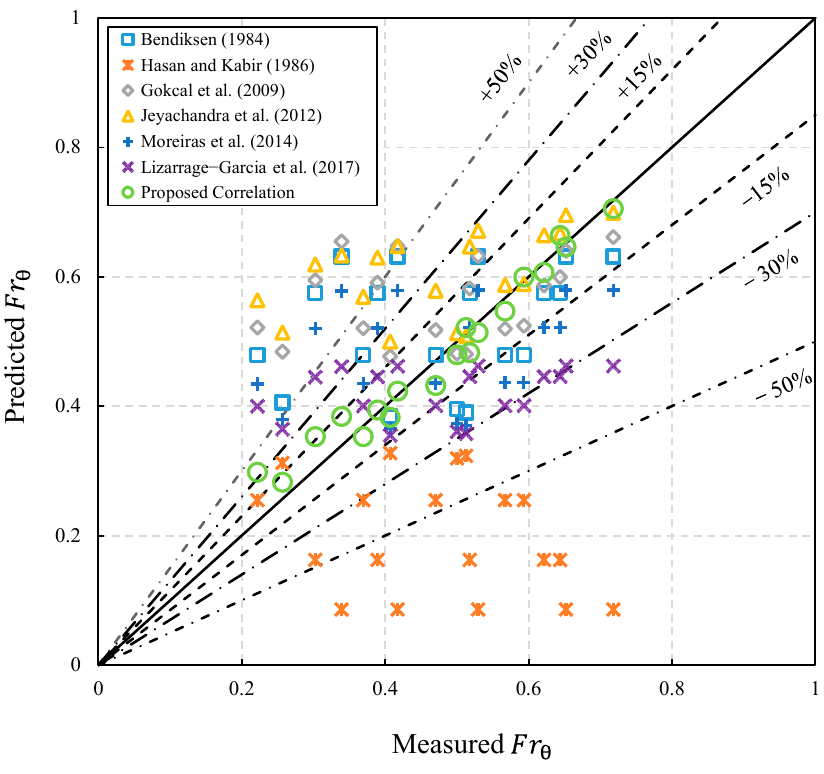
Figure 12. Performance of the proposed correlation for predicting drift velocity (dataset in Appendix A).